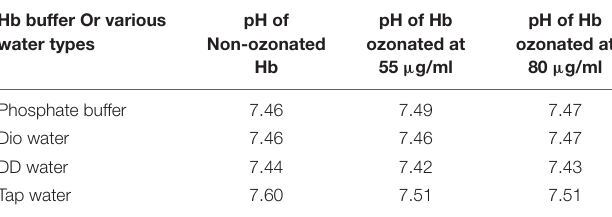
TABLE 2 | Investigating pH changes of non-ozonated and ozonated Hb samples in the presence of phosphate buffer and diluted versions with different water types. Hb buffer Or various water